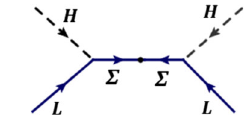
Fig. 2 Tree-level neutrino mass diagram for type-III seesaw